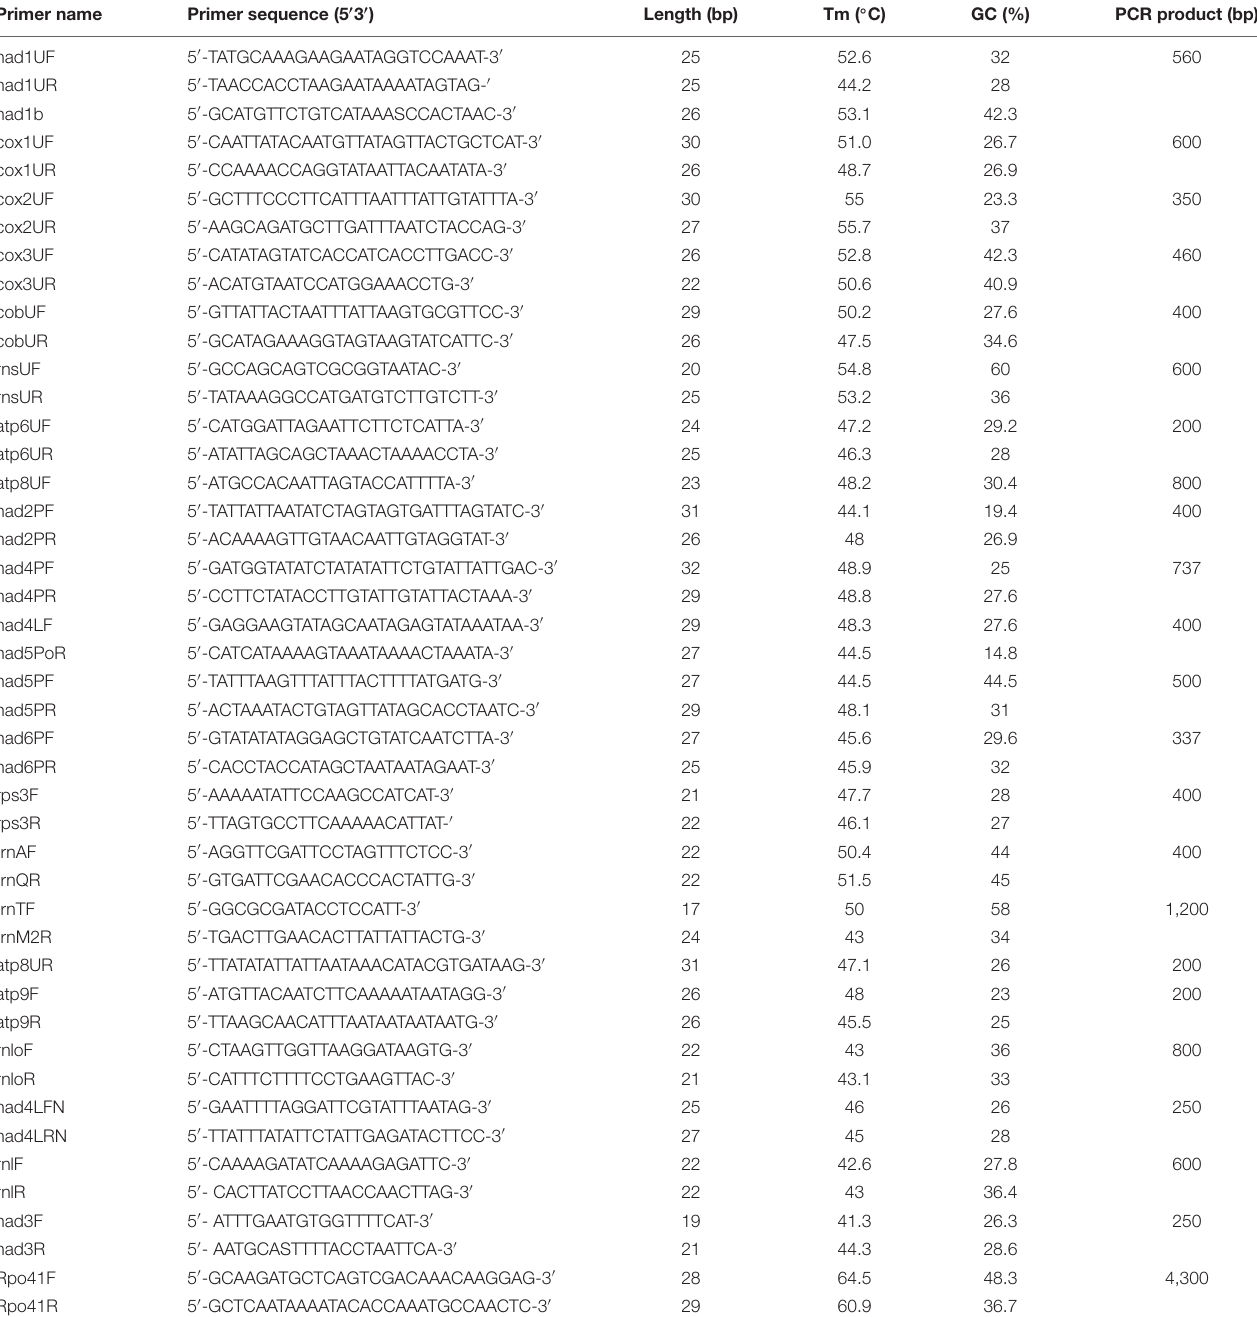
TABLE 1 | Oligonucleotide primers used for PCR and RT-PCR assays in this work. Primer